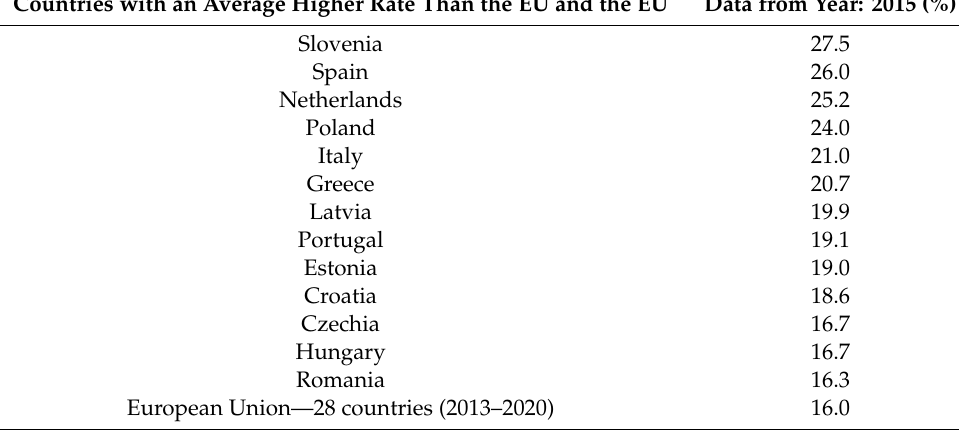
Table A4. Employed persons expecting a possible job loss over the next 6 months (Eurostat